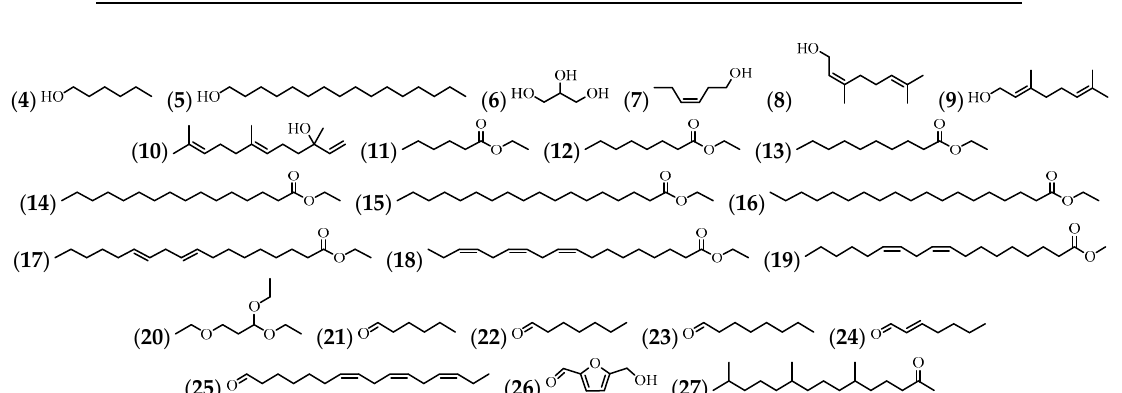
Figure 3. The structures of the alcohols, esters, ethers, aldehydes, and ketones from A. cathartica.